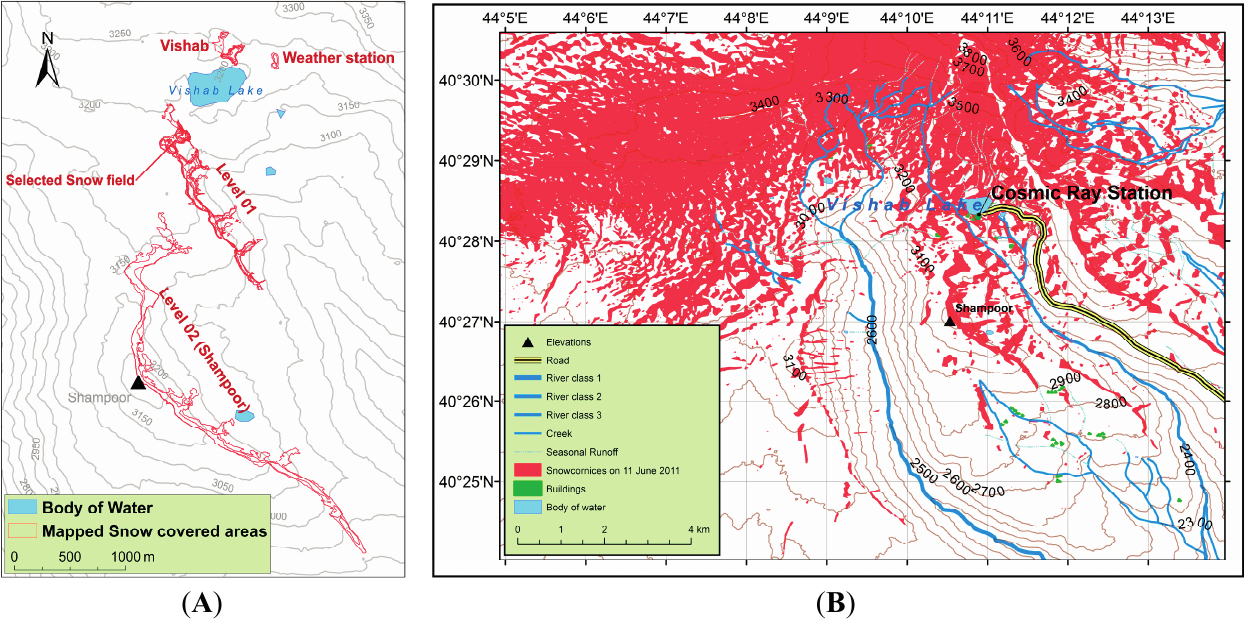
Figure 2. Mapped outlines of snow fields on Mount Aragats ( A ) based on repeated GPS mapping and ( B ) classified from a Landsat-scene taken on 6 June 2011.